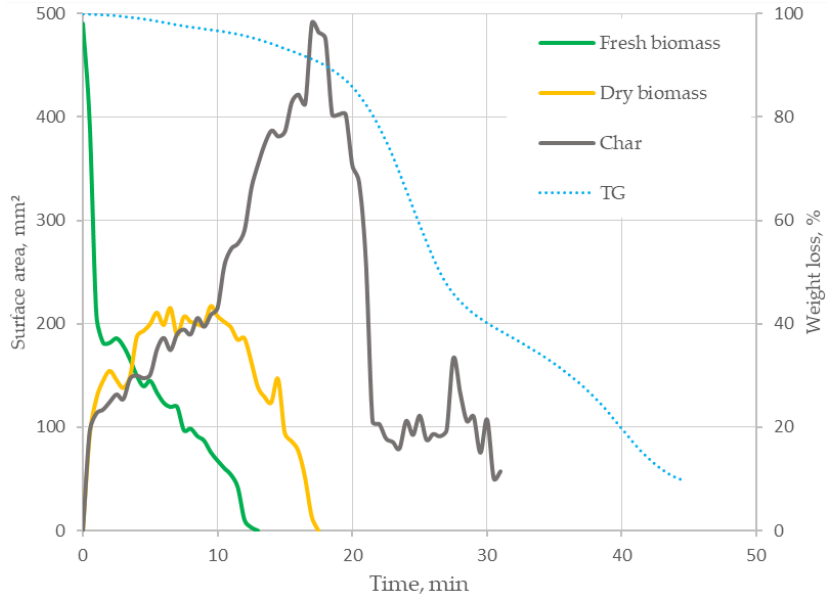
Figure 6. Change in the surface area of fresh biomass, dry biomass and char—sample 25K75J.